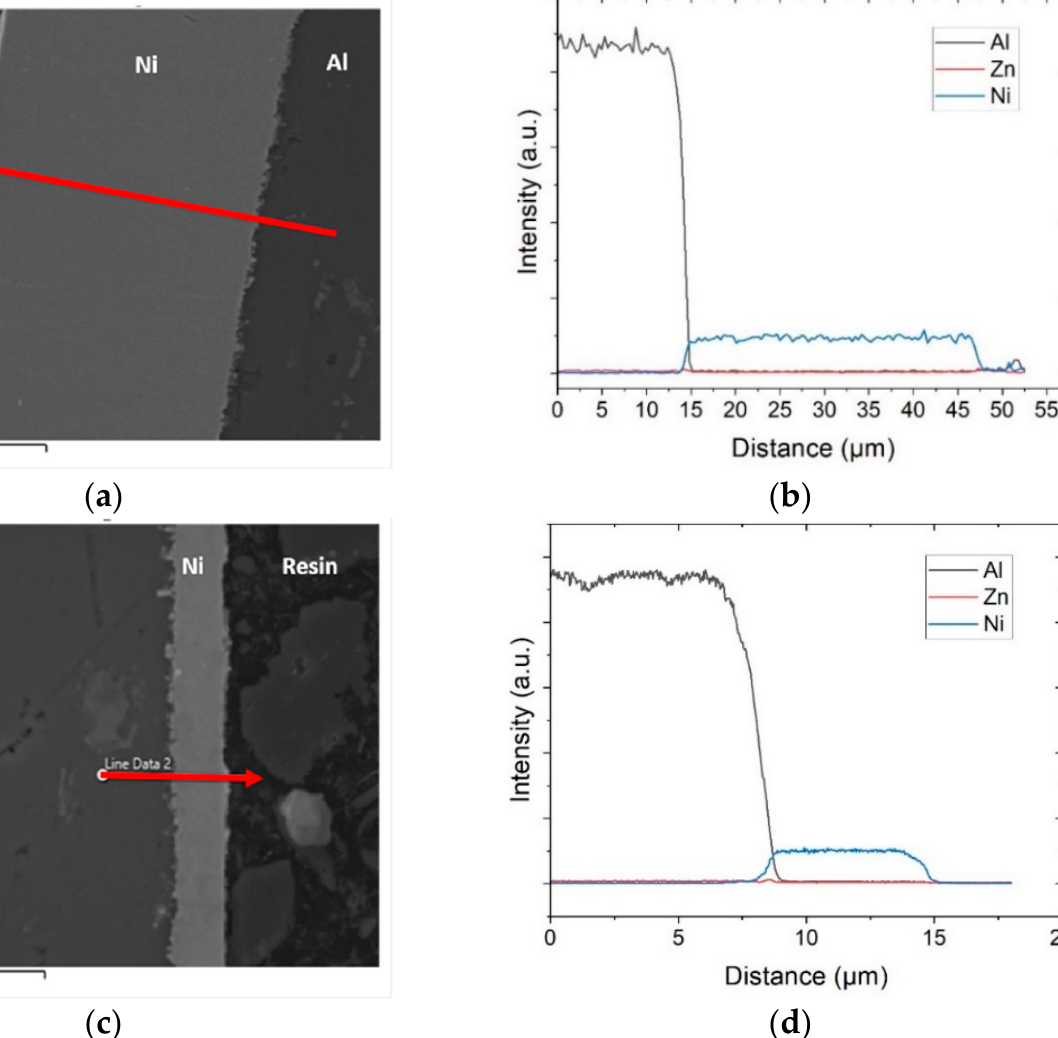
Figure 6. Polished samples subjected to the pre-treatment, zinc immersion plating and nickel electroplating: ( a ) cross-section being analysed, red arrow indicates the area and the direction of the EDS measurement for a sample nickel-plated for 40 min; ( b ) EDS profile analysis along the red arrow of Al, Zn and Ni; ( c ) same as ( a ) but for a sample nickel-plated for 40 min; ( d ) same as ( b ) but for a sample nickel-plated for 40 min.